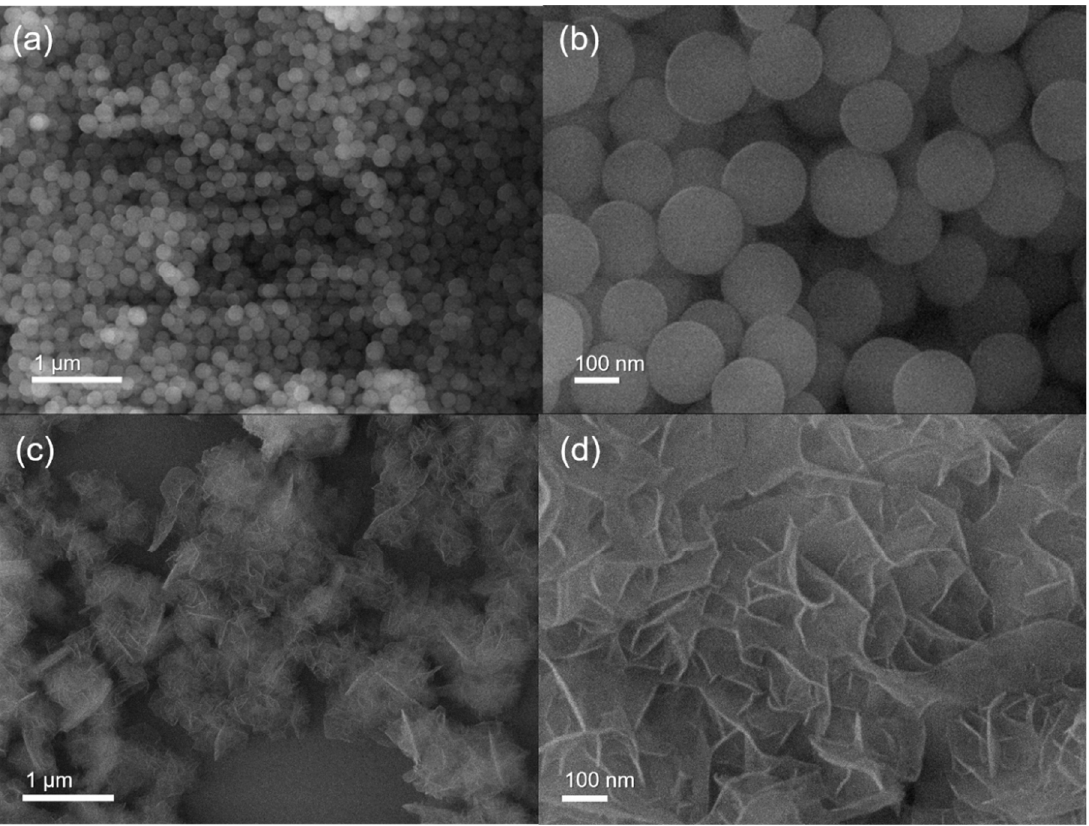
Figure 2. SEM images of ( a , b ) SiO 2 spheres and ( c , d ) Co(OH) x F 2 − x nanosheets.